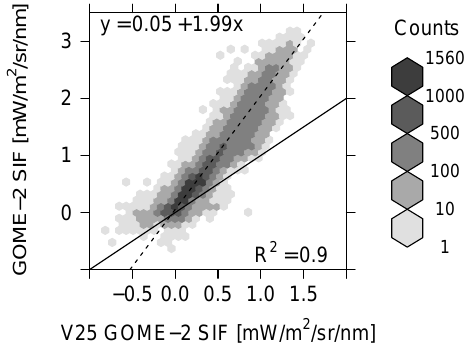
Figure 14. SIF retrieval results from the presented algorithm ver- sus V25 results provided by Joiner et al. (2014). SIF averages from February 2007 to December 2011 (rastered on a 0 . 5 ◦ × 0 . 5 ◦ grid) with cloud fractions lower than 0.5 have been used. The one-to-one line (solid line) is depicted as well as a linear fit (dotted line).